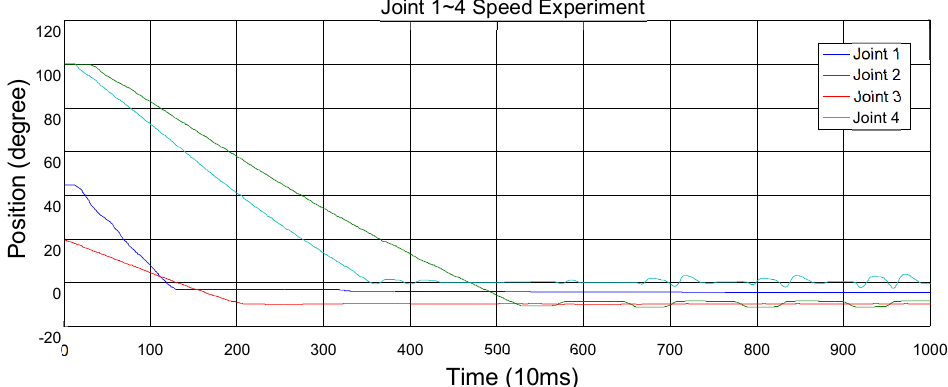
Figure 16. Four axes—curve of position rise versus time.